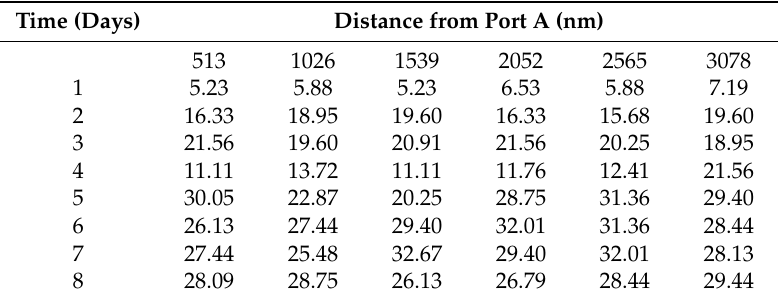
Table A4. Wind speed (in kn) as a function of time and space in Winter.